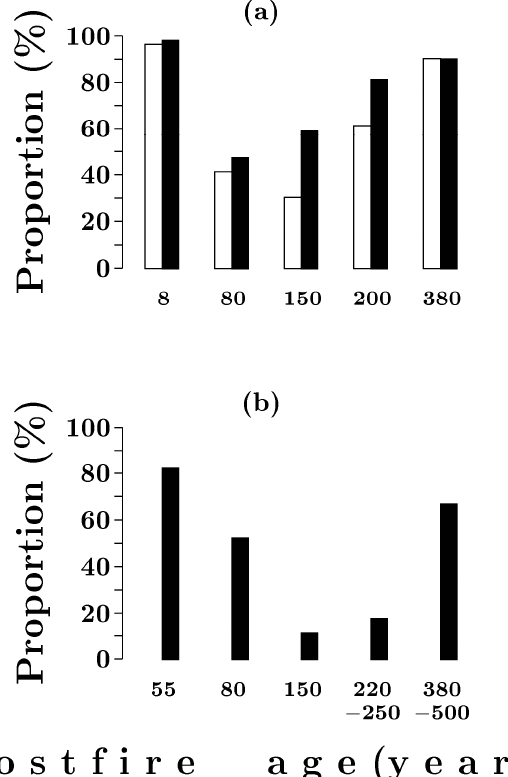
Figure 5. The proportion of seedlings in Pinus sylvestris (open bars) and Picea obovata (solid bars) populations in Siberian spruce–Scots pine ( a ) and Siberian spruce ( b ) forests with different post-fire periods.